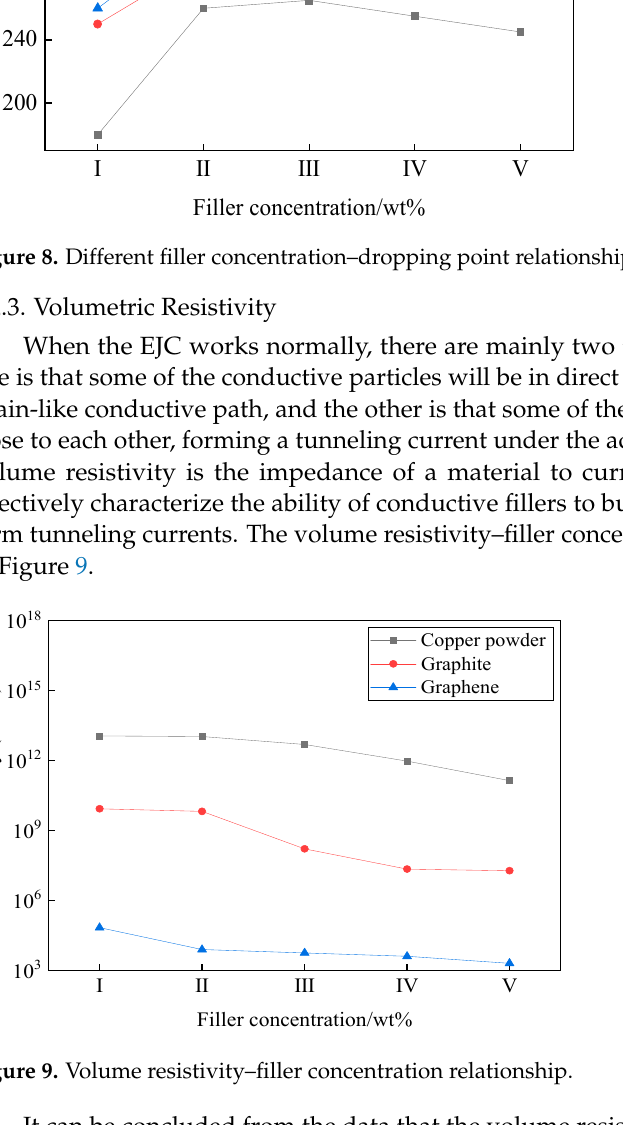
( B ) Figure 10. The relationship between the frictional properties of the EJC and the MEG. ( A ) Average friction coefficient; ( B ) Average abrasion diameter. Figure 10a shows the relationship between the average friction coefficient and MEG content. With the increase of MEG content, the friction coefficients of all electric power complex greases decreased first and then increased. When the MEG content was 4 wt%, the friction coefficient was the smallest, and the electric power complex grease had the